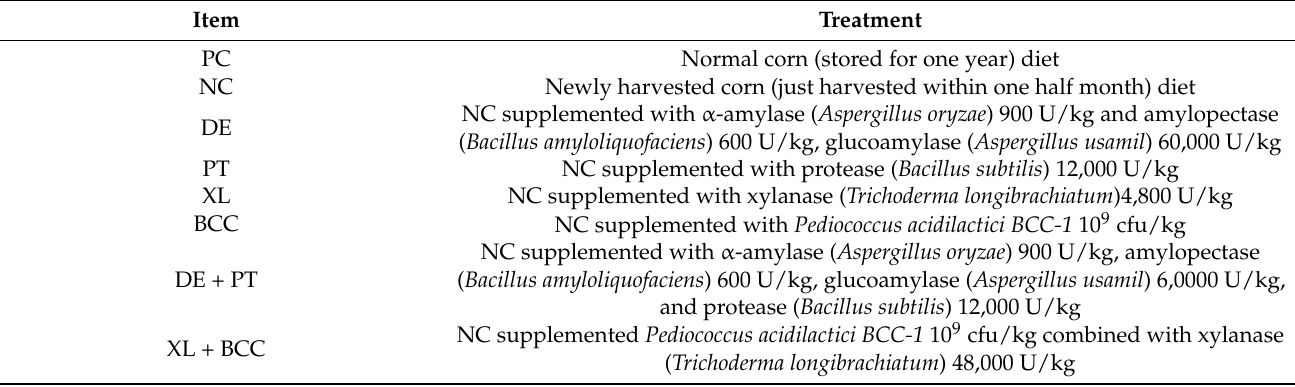
Table 1. Treatment of the